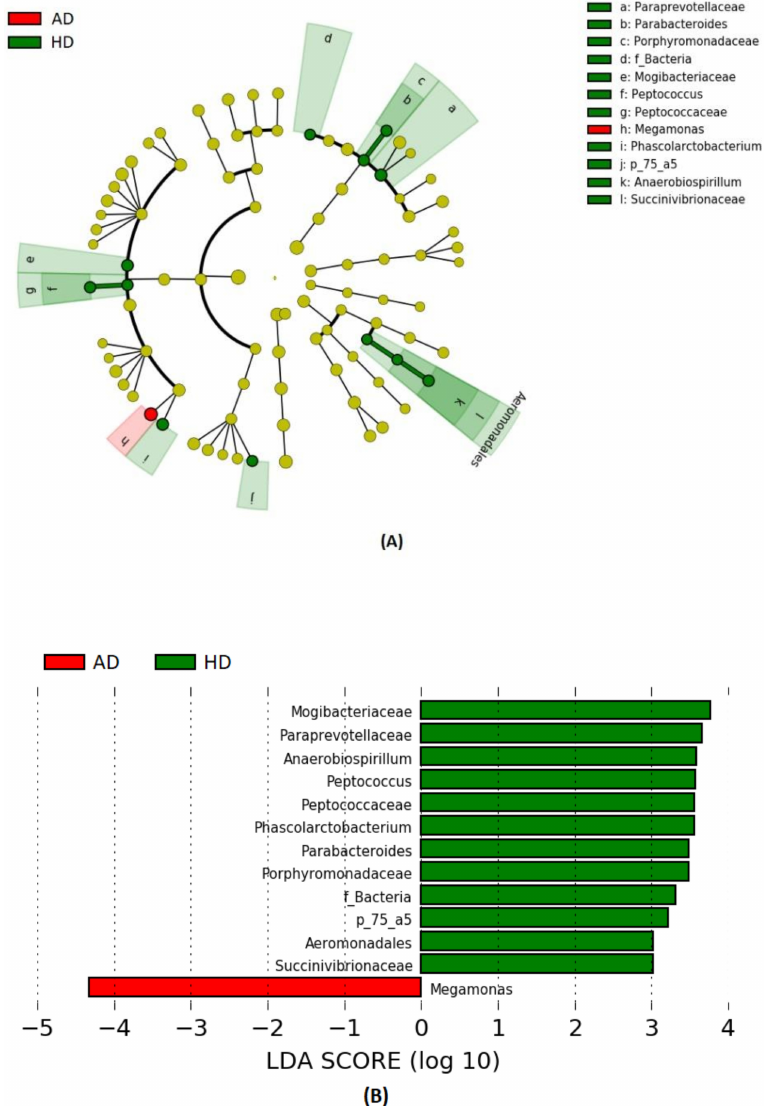
Figure 3. Bacterial taxa were significantly more abundant in the feces of healthy (HD) and arthritic dogs (AD). The cladogram ( A ) highlights impactful communities in individuals from each status, and ( B ) shows the score of the linear discriminant analysis (LDA, significant threshold >